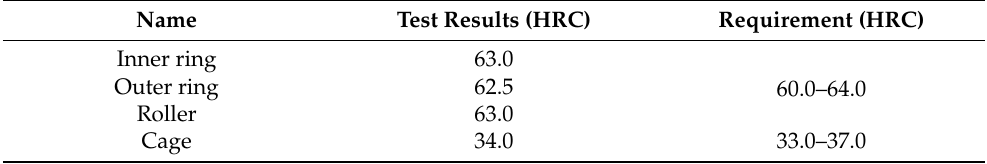
Table 5. Hardness test results and requirements of the inner ring, outer ring, rollers, and